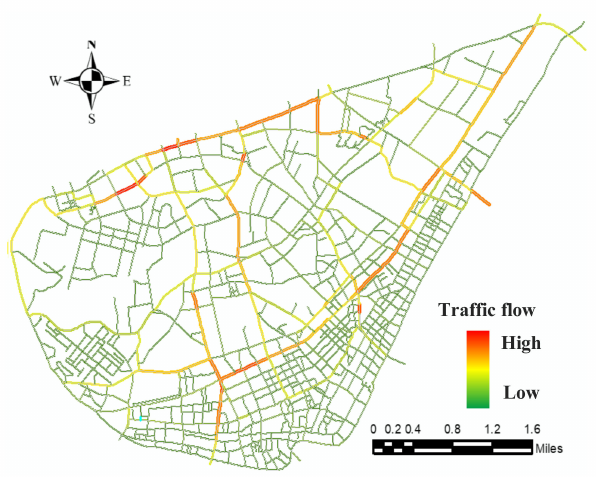
Figure 10. Spatiotemporal pattern of routing schemes in the Hankou commercial district of Wuhan, China.